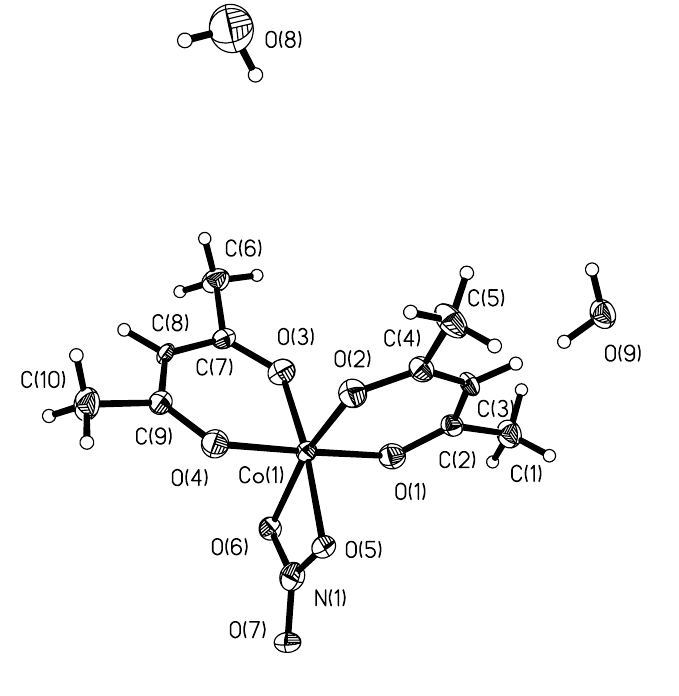
NO ]·2H O ( 2 ) at 30% probability 2 3 2